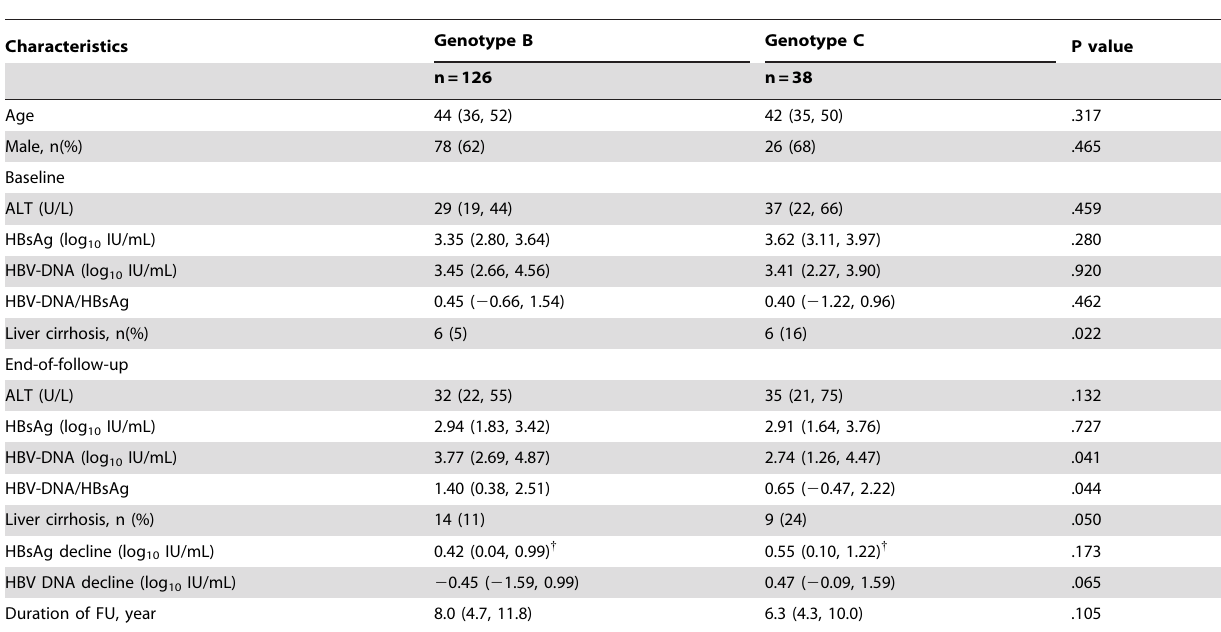
Table 3. Characteristics of patients according to HBV genotype B or C.